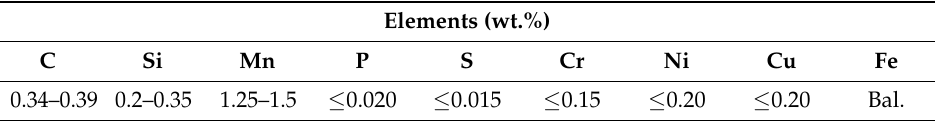
Table 1. Chemical composition of type J55 carbon steel (wt.%).